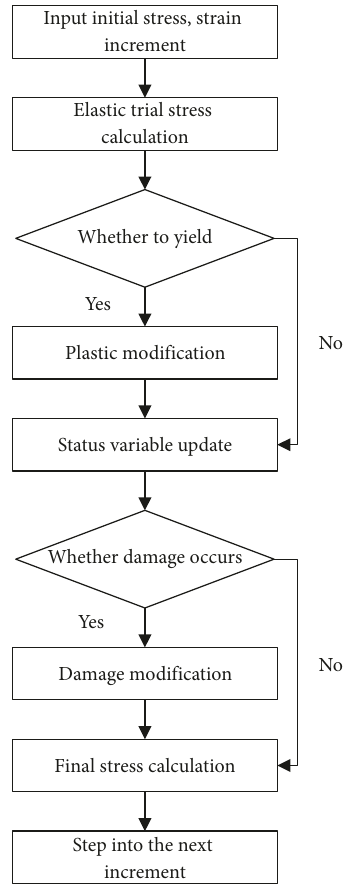
Figure 2: Numerical realization flow chart of elastoplastic damage constitutive